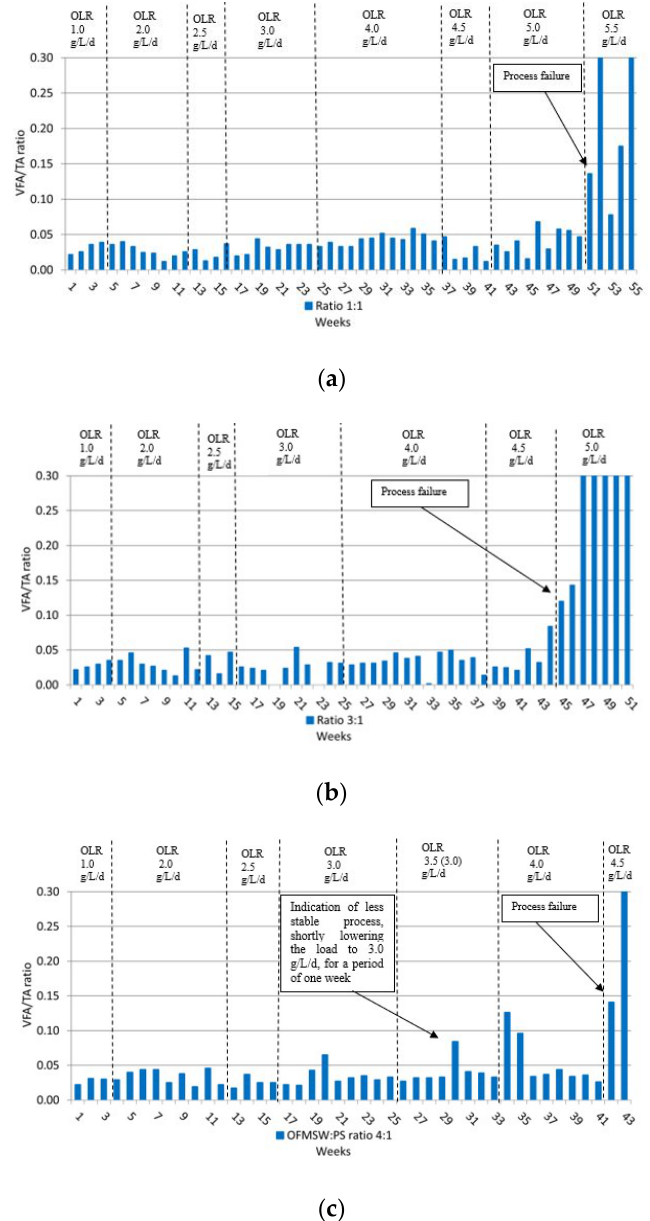
Figure 1. The ratio between volatile fatty acids (VFA) and total alkalinity (TA) in the co-digestion reactors treating Organic Fraction of Municipal Solid Waste (OFMSW) and primary sludge (PS) at different ratios: ( a ) OMSW:PS of 1:1; ( b ) OMSW:PS of 3:1; ( c ) OMSW:PS of 4:1. The OLR:s applied are presented at the top of each figure and the regions were process failure occurred are pointed out in each figure with an arrow.